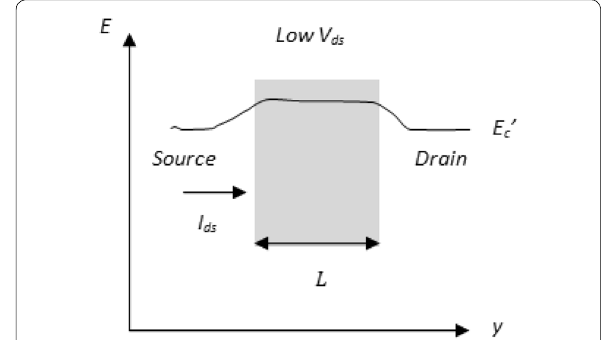
Fig. 4 MOSFET band diagram under low drain bias conditions. Here L > (cid:31) condition is considered, so that scattering is uniform throughout the channel